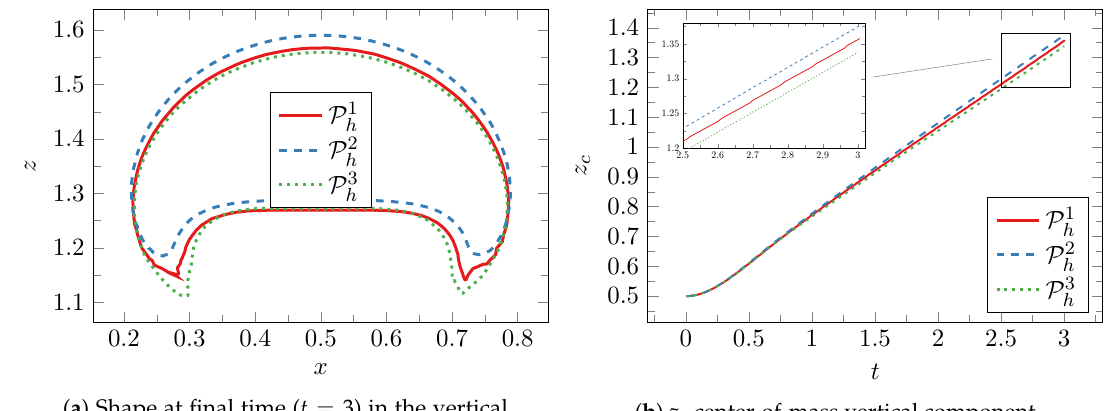
, P 2 and P 3 simulations for the ellipsoidal test case ( h = 0.02). h h h